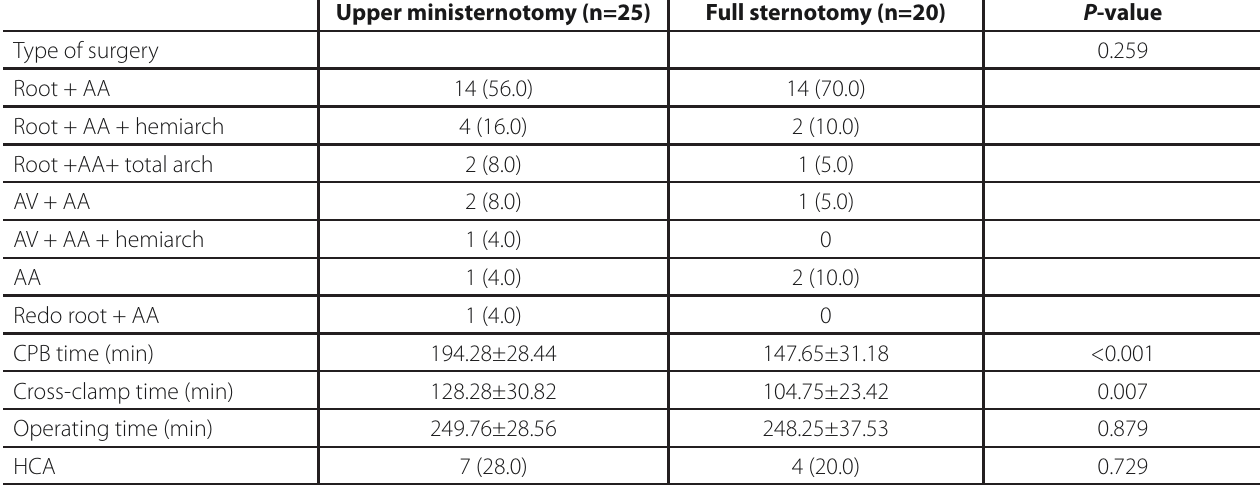
Table 2. Intraoperative variables.